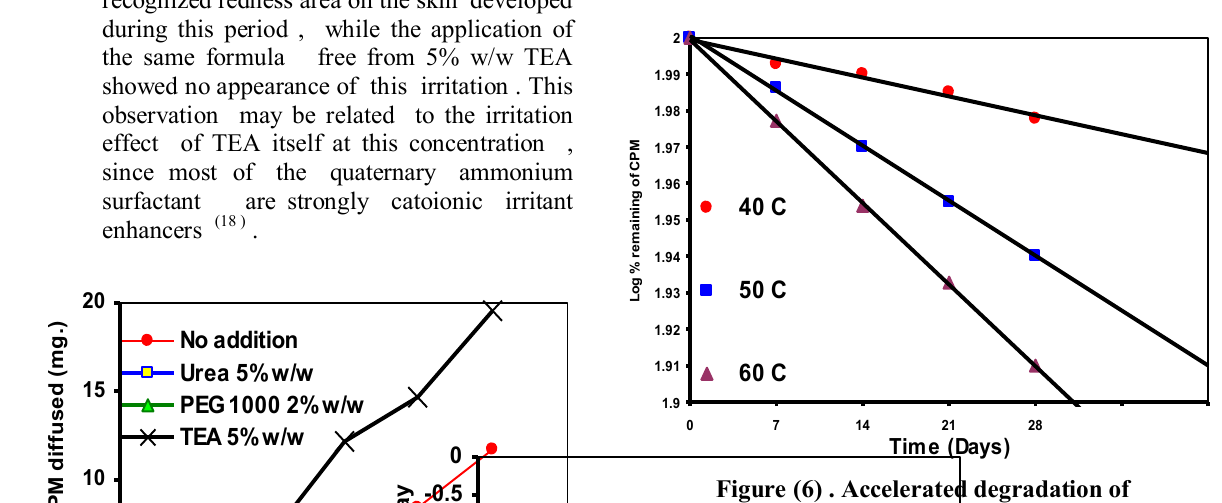
Figure (6) . Accelerated degradation of CPM in a selected formula at different exaggerated temperatures